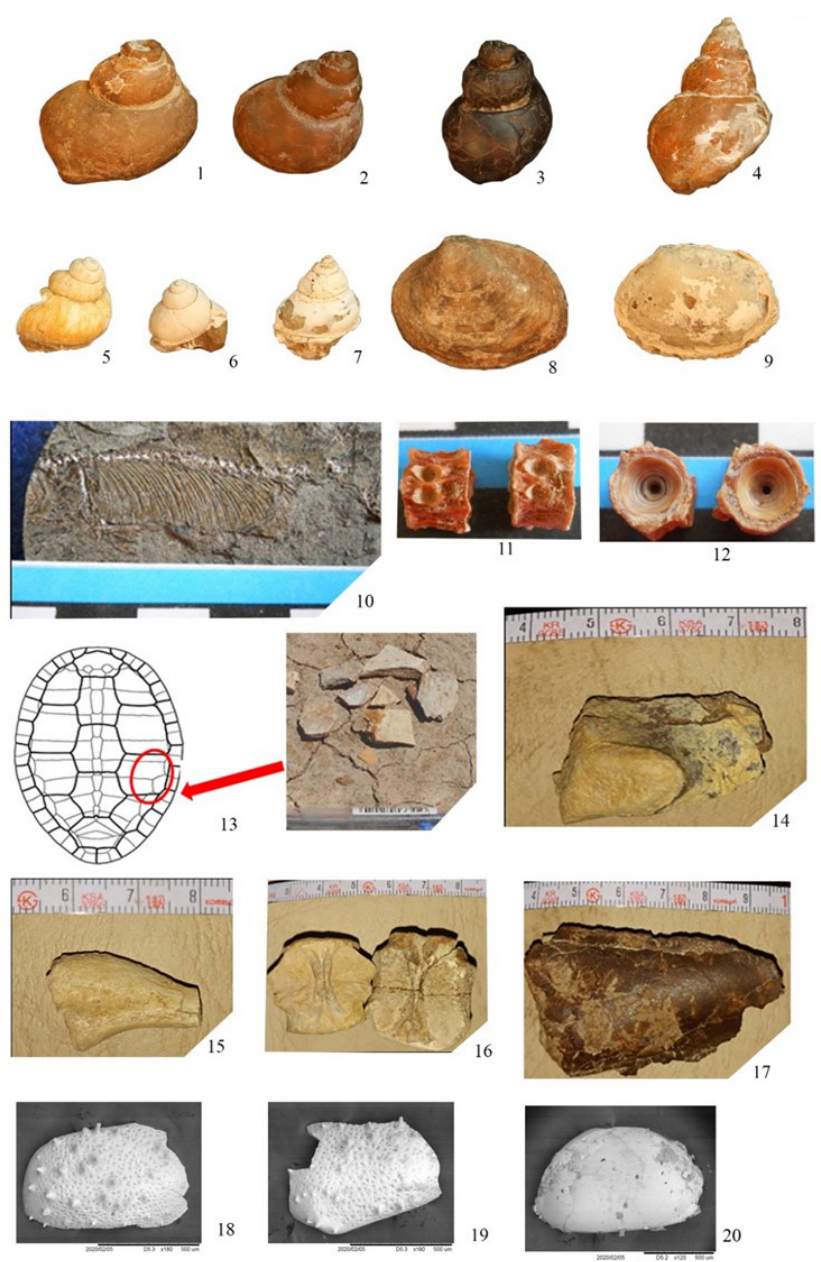
Plate II. Figs. 1-20. 1-3: Viviрarus robustus Martinson, Lower Cretaceous, Barremian; 4 -Campeloma yihsiensis Grabau, Lower Cretaceous, Barremian; 5 and 6 : C. mongolica Martinson, Lower Cretaceous, Barremian-Aptan; 7 : Lioplax sp . ; 8 and 9: Unio pygmaeiformis Martinson, Lower Cretaceous, Barremian; 10- Lycoptera sp., Lower Creatceous; 11 and 12: Peipiaosteus sp., Lower Cretaceous; 13 : Hangaiemys leptis Sukhanov emend Narmandakh, Lower Cretaceous; 14, 17: Dinosaur bone fossil-15 and 16: Psittacosaurus sp., Lower Cretaceous, Aptian- Albian (?); 18-20- Ostracods: 18- Cypridea copulenta Lubimova; 19- Limnocypridea grammi, Lubimova; and 20- Lycopterocypris infantilis Lubimova, Lower Cretaceous,